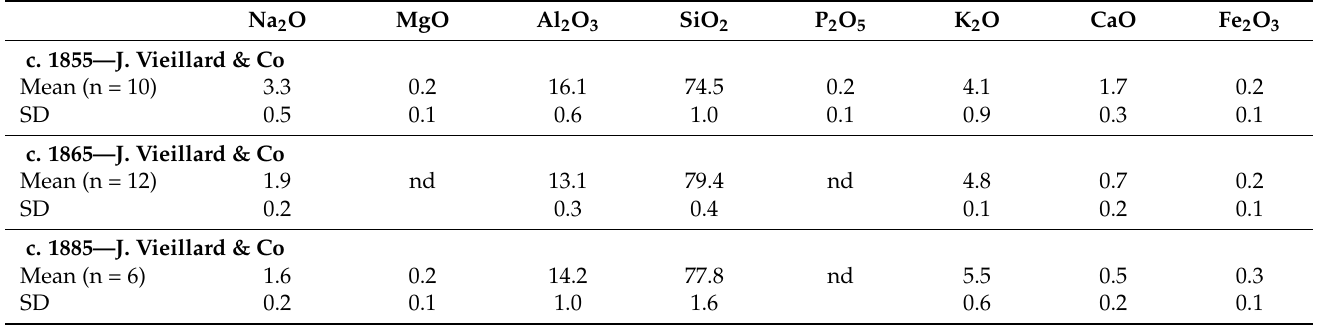
Table 5. Average chemical composition and standard deviation of the glaze, measured by EDS analysis (wt% normalized to 100%). The data are the average over at least two analyses taken in different areas of the ceramic bodies. SD = standard deviation; nd = non